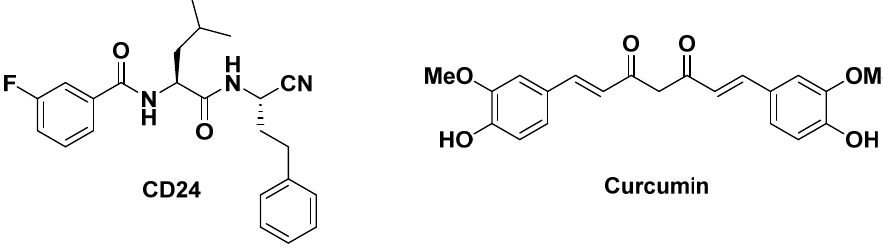
Figure 1. Structures of CD24 and